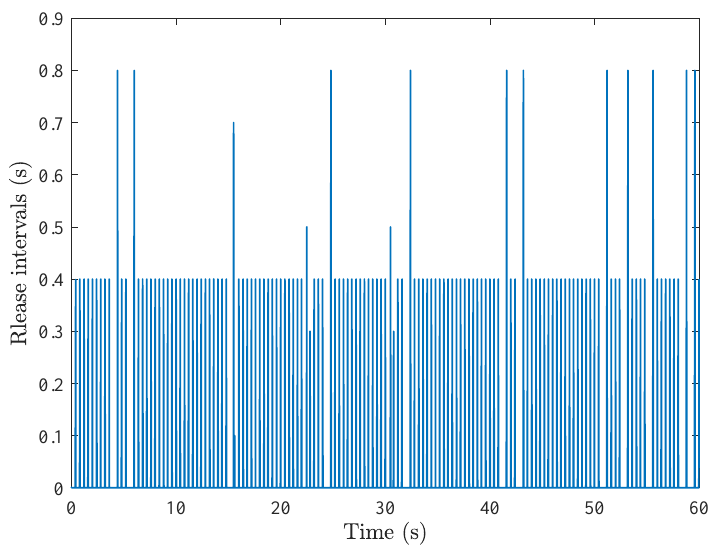
Figure 7. Event-triggered instants of sensor 1.